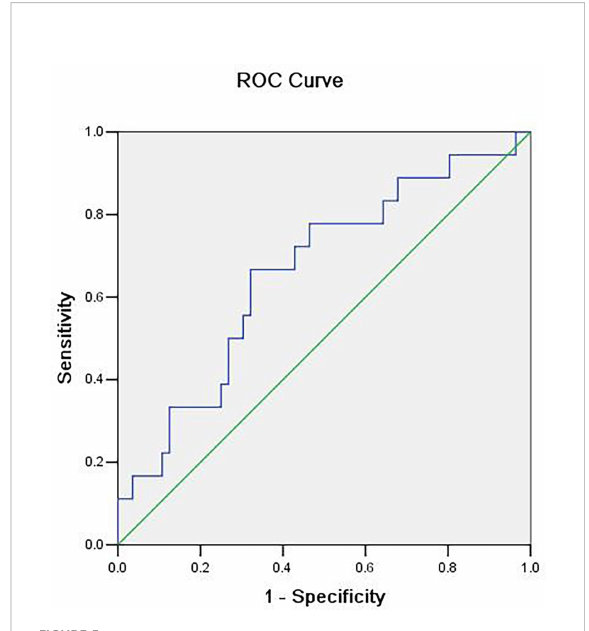
FIGURE 5 The receiver operating characteristic (ROC) curve of sum power of two frequency points (0.1508 and 0.1534 Hz). The area under the ROC curve value was 0.661 (P = 0.041). The cutoff value is 1.41241, which means that, if the sum power value is greater than or equal to 1.41241, then it is considered benign MSK tumor with sensitivity of 67% and speci fi city of